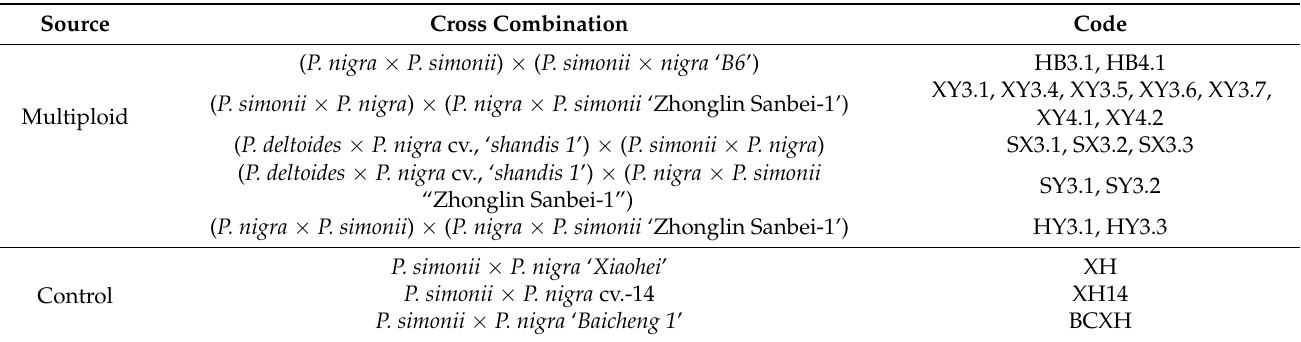
Table 1. Number and name of poplar